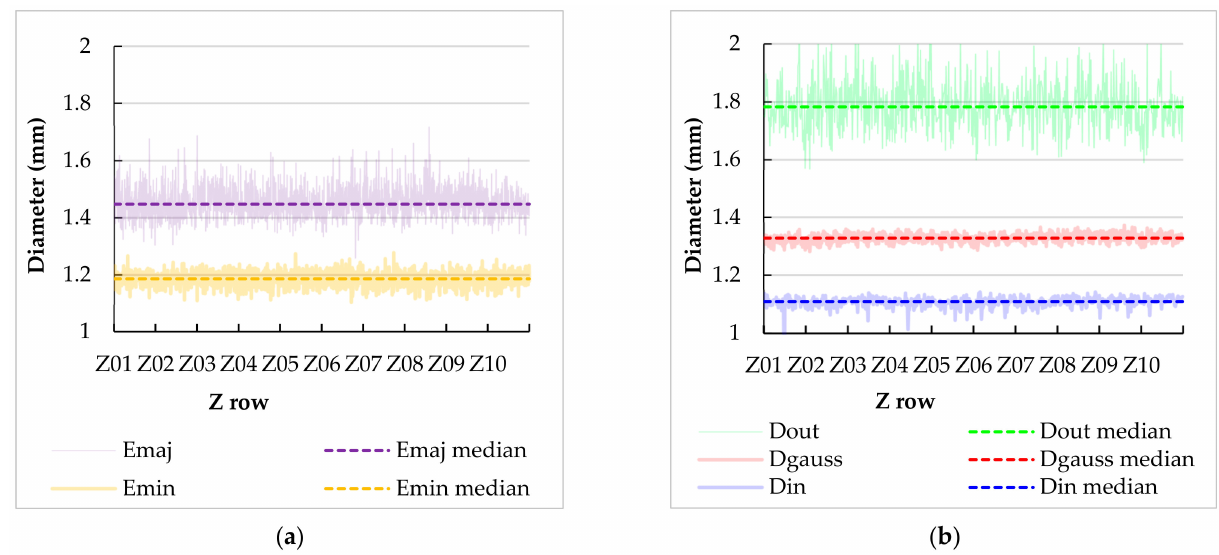
Figure 8. Values of strut characteristics of structure #6. ( a ) Major and minor axes of ellipses. ( b ) Minimum circumscribed, maximum inscribed, and Gauss cylinder’s diameters.